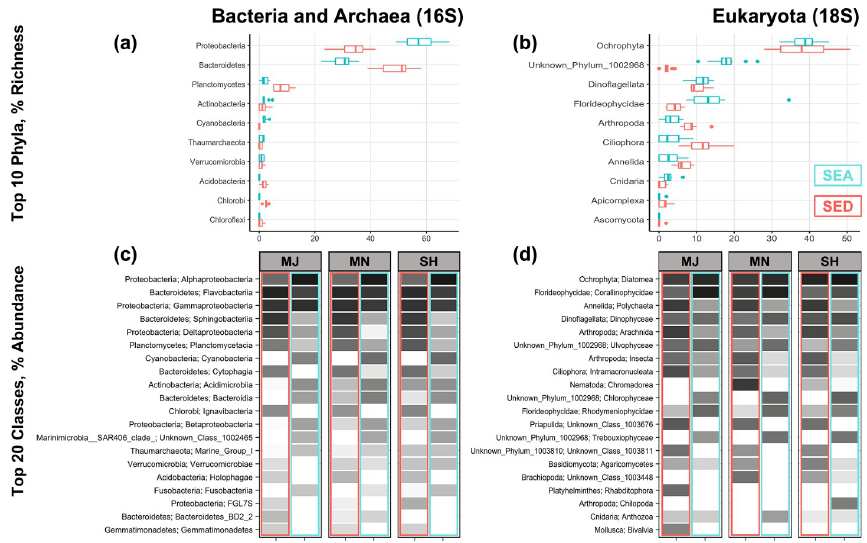
Fig 3. Microbial phyla by richness and abundance. Top phyla by richness differ by environment type, with some abundance specificity by site location. (a-b) The top 10 bacterial and archaeal as well as eukaryal phyla across biological replicates of site locations for both seawater (SEA) and sediment (SED) environment types from most to least richness in the sediment in order of highest relative abundance to lowest. (c-d) The top 20 bacterial and archaeal as well as eukaryal classes, demonstrating variation in abundance by environment type and site location from a gray-scale gradient of white (0) to black (100). Common or rare phyla and classes can be additionally viewed by comparison of OTU